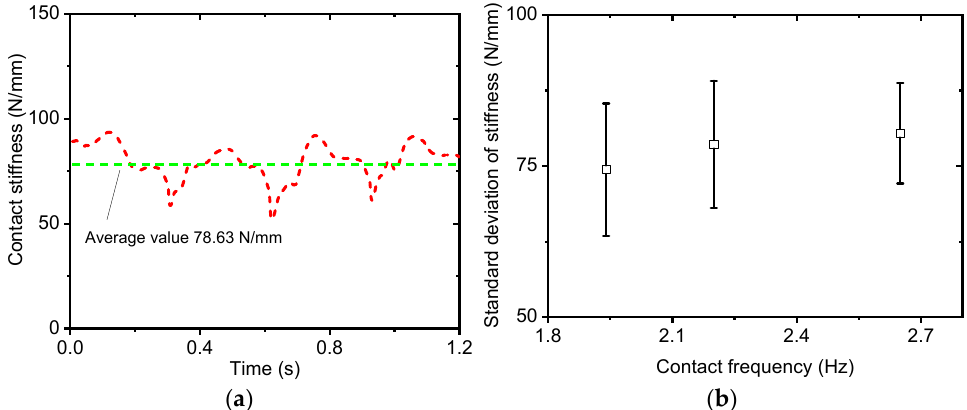
Figure 13. Estimates of stiffness in real collisions ( f = 2.2 Hz). ( a ) Identified results. ( b ) Standard deviation.